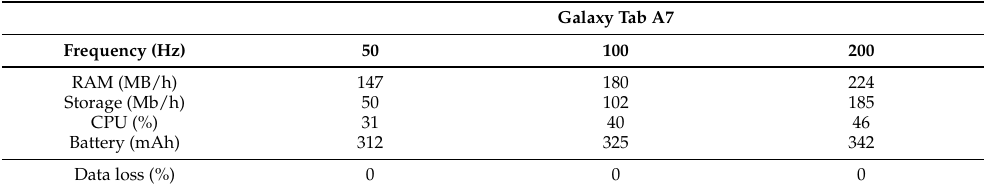
Table 6. Data aggregators’ profiling using Android Studio